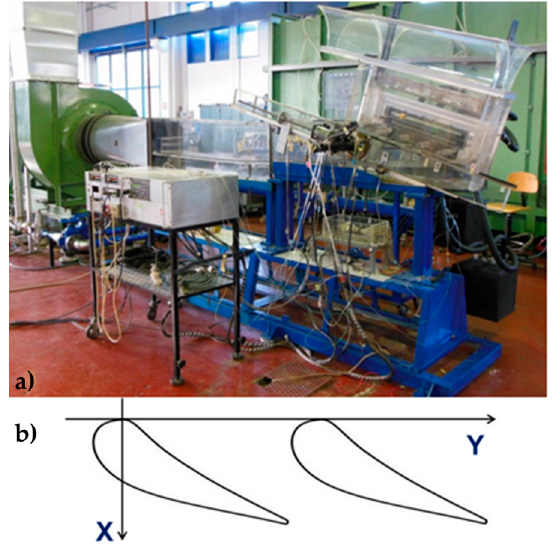
Figure 1. ( a ) View of the wind tunnel; ( b ) cascade model.